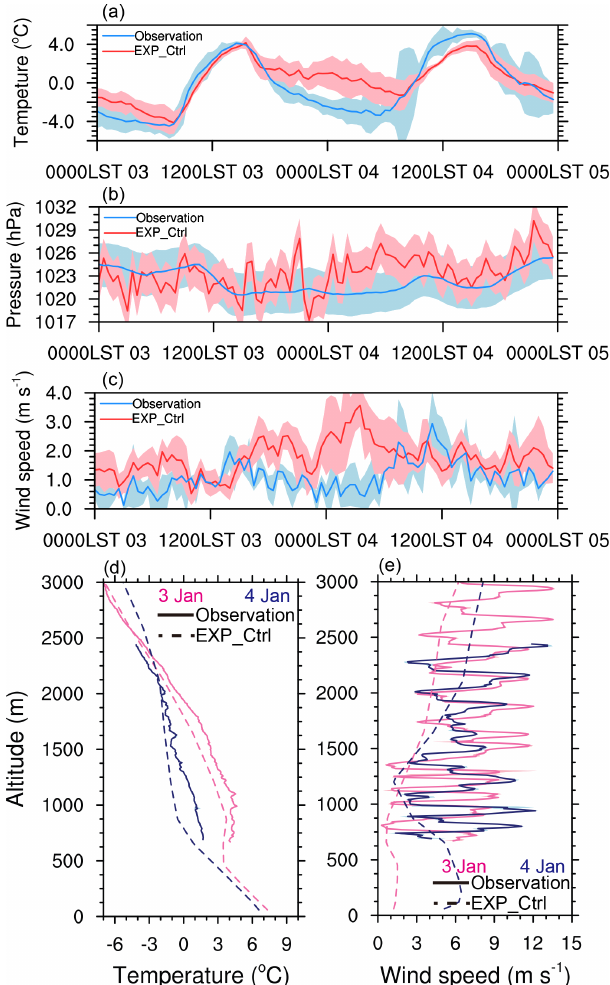
Figure 2. Validation of meteorological parameters. (a–c) Time se- ries of 2m temperature, surface pressure, and 10m wind speed in Beijing between the modeling (EXP_Ctrl) and ground-based obser- vation, respectively. (d–e) Vertical profiles of temperature and wind speed in Baoding between the modeling (EXP_Ctrl) and aircraft observation, respectively. The shaded areas indicate the error bars (standard